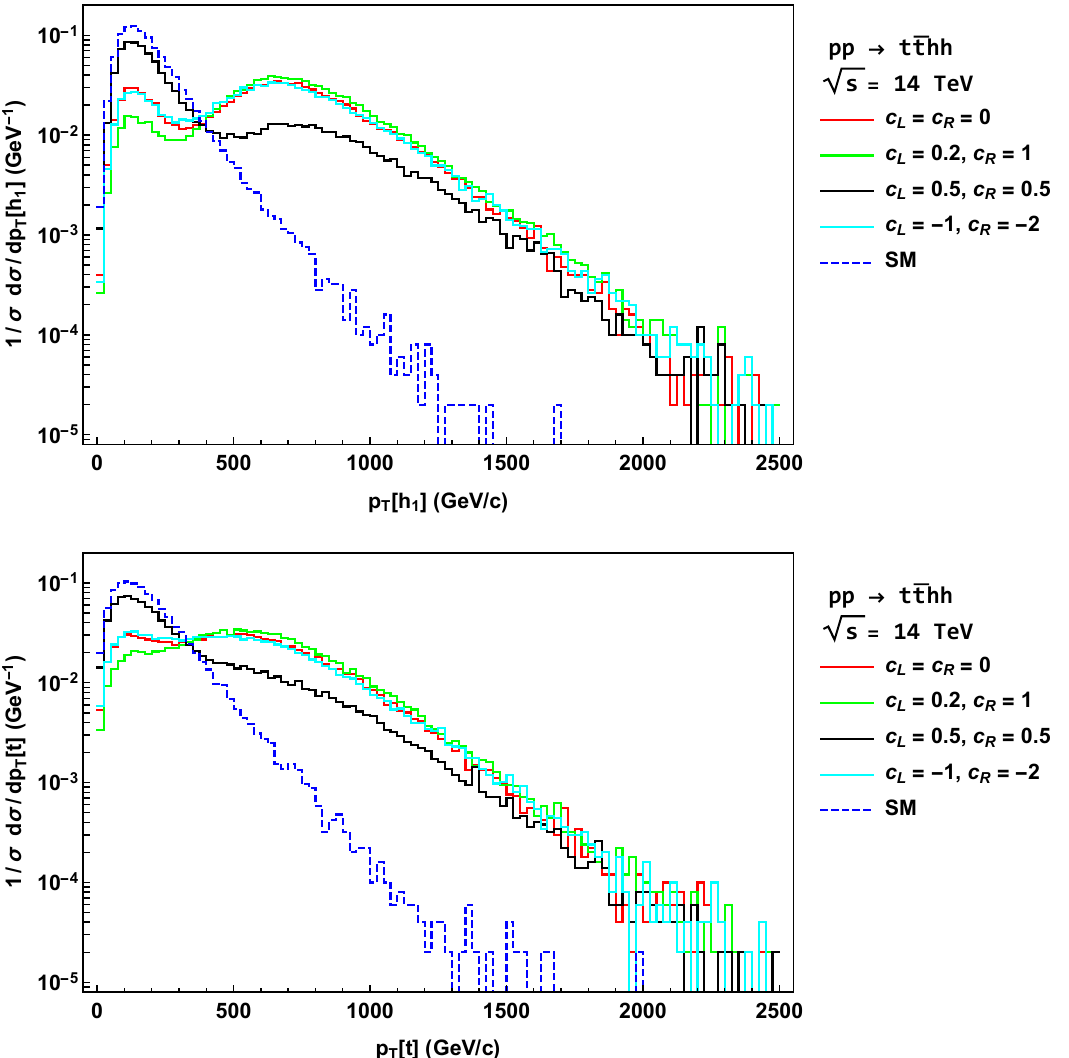
Figure 6 . p t distribution of the most energetic Higgs ( h 1 ) and the top particle for 4 combinations of ( c L , c R ) in the MCHM 5 ( M 1 = − 0 . 96 TeV, M 4 = 1 . 4 TeV, f = 1 . 2 TeV, y L = 0 . 88 ). The SM is shown for comparison and all curves are normalized to unity area. Histograms generated with MadAnalysis 5